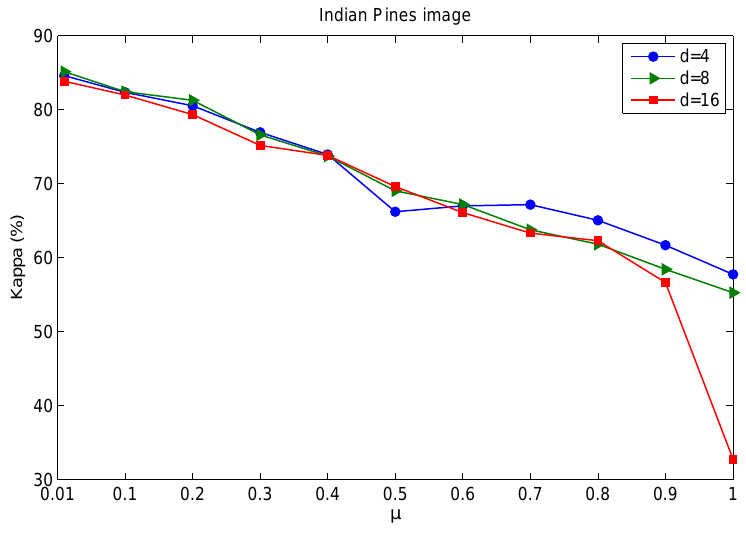
Figure 7. Influence of µ and d on the Kappa coefficient of ELP-RGF for the Indian Pines